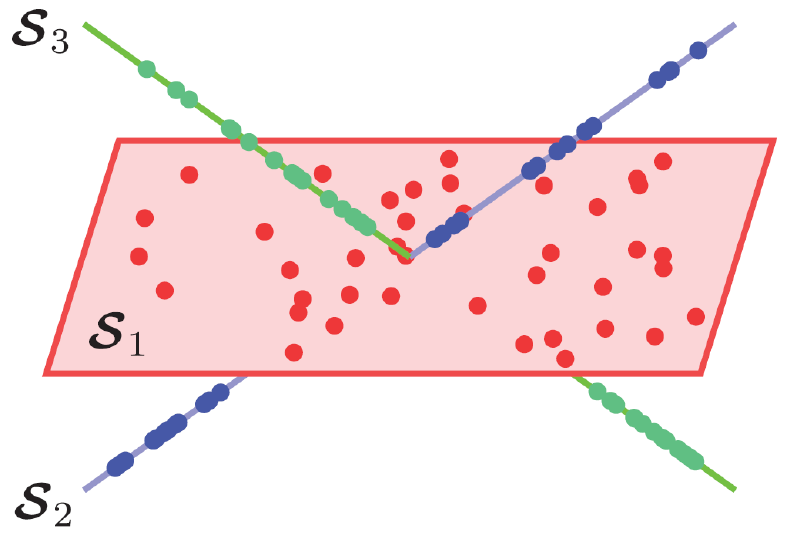
Figure 1. A set of sample points in R 3 from a union of three subspaces: a plane and two lines. Definition 1 (Subspace clustering, SC [38]) . Given a set of samples X = [ x 1 , . . . , x n ] ∈ R d × n , where d and n are the number of features and samples, respectively. Assume that X are drawn from a union of k subspaces {S i } k with unknown dimensionality { d i } k . Subspace clustering aims to i = 1 i = 1 segment the samples according to the underlying subspaces which they are drawn